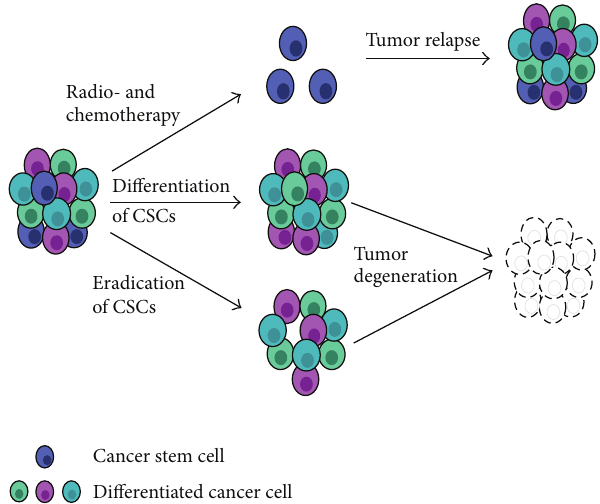
Figure 3: Therapies to target radio- and chemoresistant cancer stem cells. The presence of cancer stem cells (CSCs) in the tumor can lead to a relapse following conventional therapy. Newly developed strategies propose to either differentiate or eradicate CSCs, leading to the degeneration of the